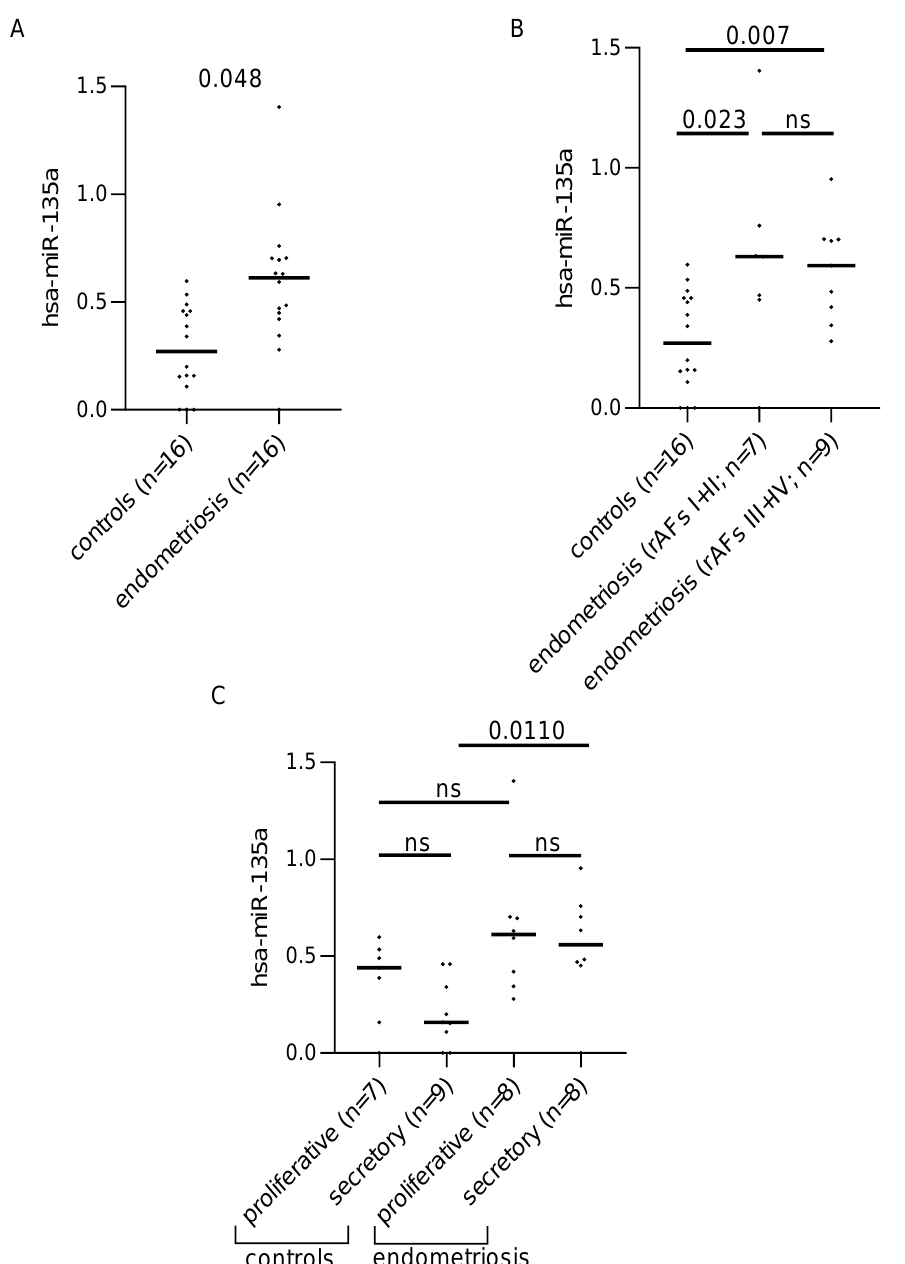
Figure 2. Plasma hsa-miR-135a levels are increased in women with endometriosis. ( A ) Graphical representation of the differences in the levels of expression of hsa-mir-135a in the plasma of women with and without endometriosis. ( B ) The influence of the disease stage on hsa-mir-135a expression levels. ( C ) The effect of menstrual cycle phase on hsa-mir-135a levels in plasma. Significant differences between the groups were detected by a Mann–Whitney U -test followed by correction for multiple testing applying Bonferroni–Holm algorithms. The adjusted p -values of each comparison are shown on the graphs. Abb.: ns = not significant.